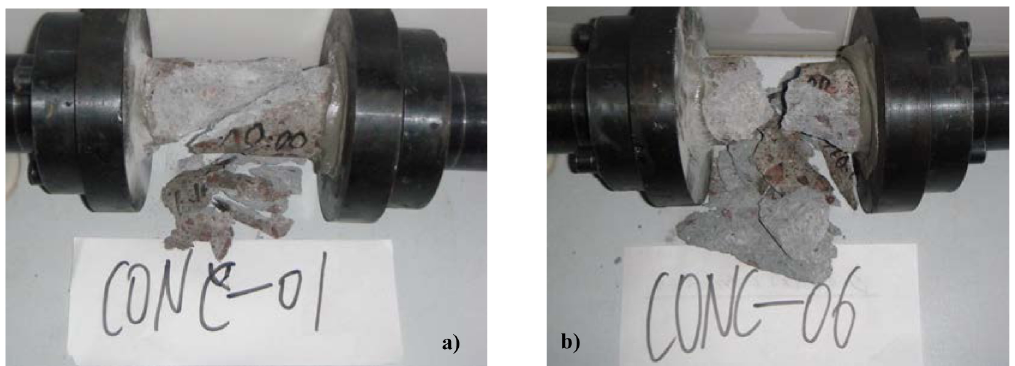
Fig. 8. Photograph of the final damage stage: a) CONC_1 in the static loading case; b) CONC_6 in the dynamic loading case